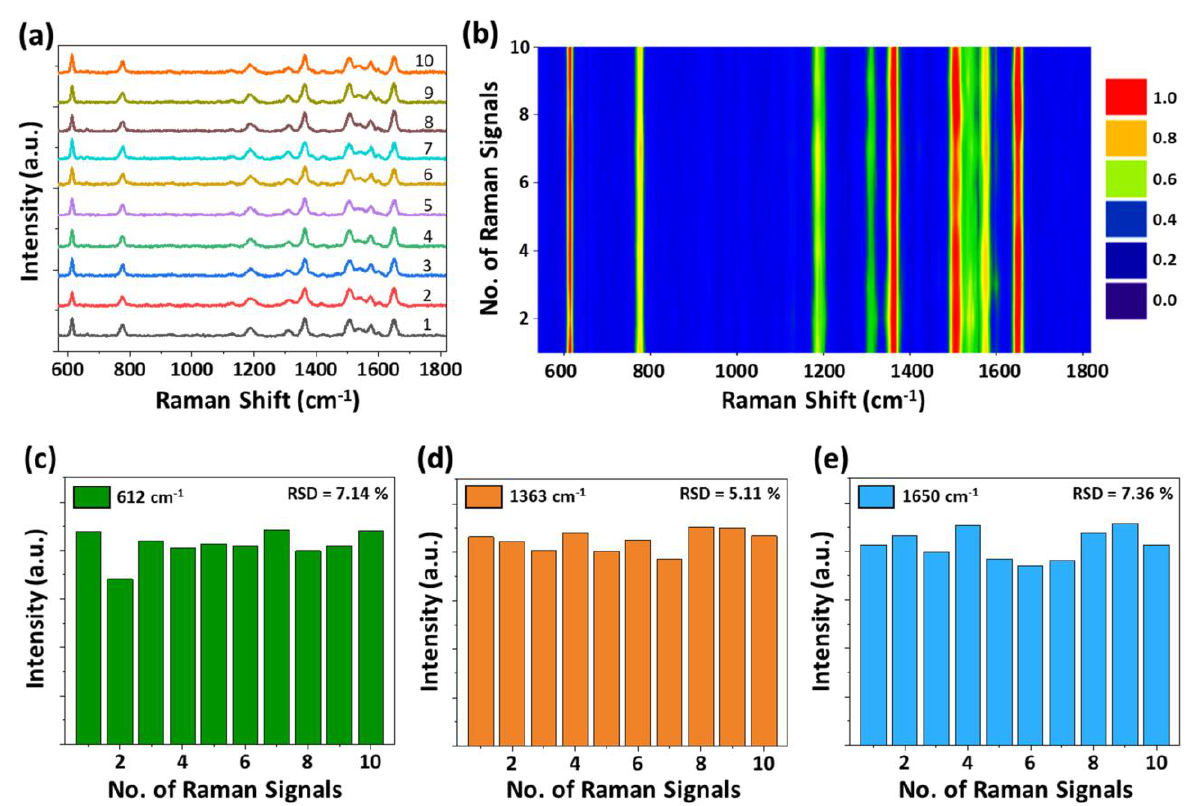
Figure 4. Reproducibility of SERS signals on a PCSS nanostructure-based SERS substrate. ( a ) SERS spectra of R6G molecules recorded from 10 different spots on the SERS substrate. ( b ) The corresponding SERS contour from a line mapping of 10 spots. ( c – e ) SERS intensity distribution of the 612, 1363, and 1650 cm − 1 Raman peaks.